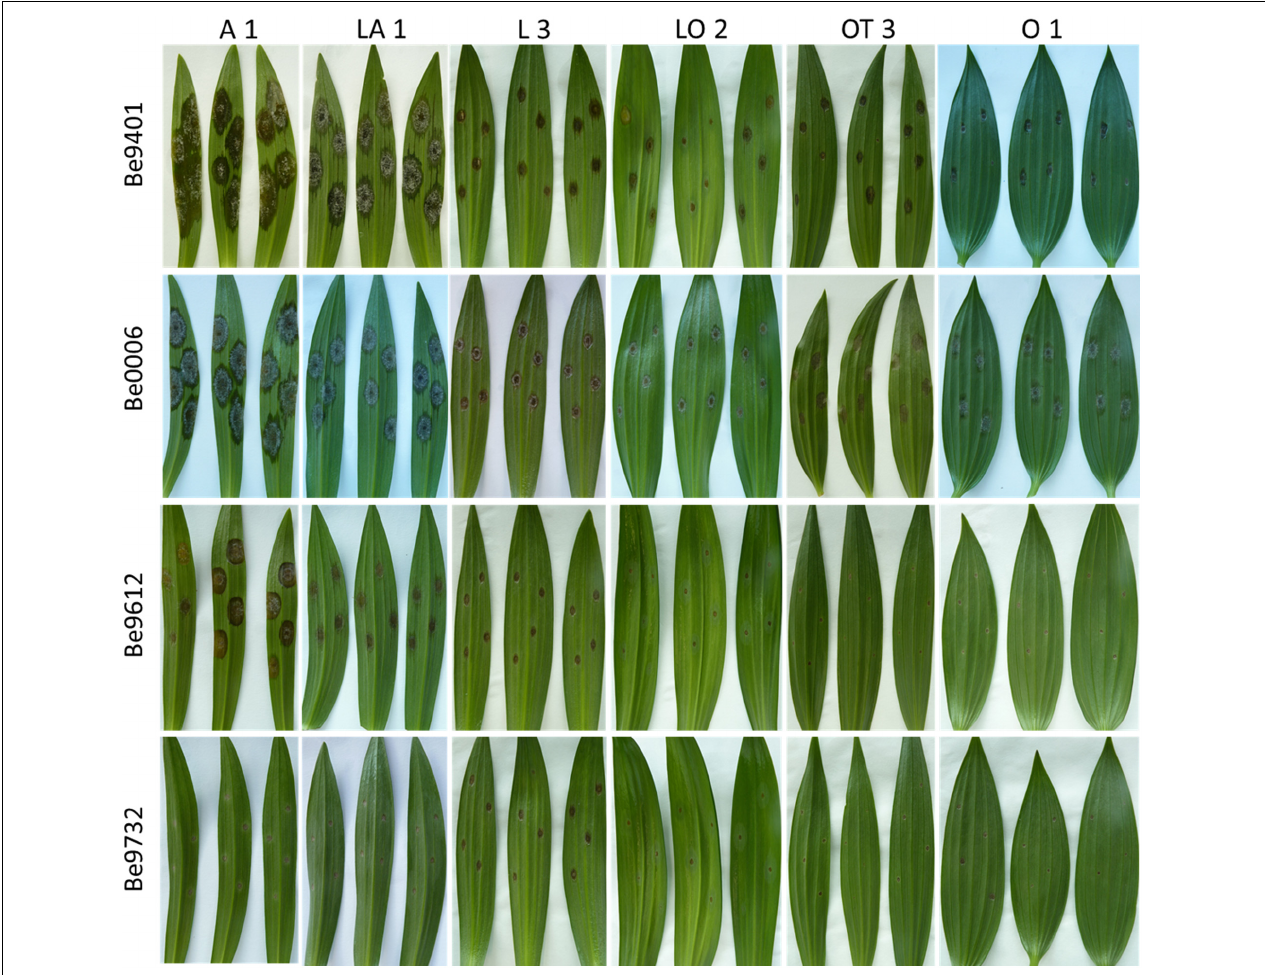
FIGURE 2 | Necrotic lesions at 4 dpi upon inoculation with four distinct B. elliptica isolates (specified in left margin) on leaves of six lily genotypes (specified at the top). For each repetition of the disease assay, three representative leaves are shown.